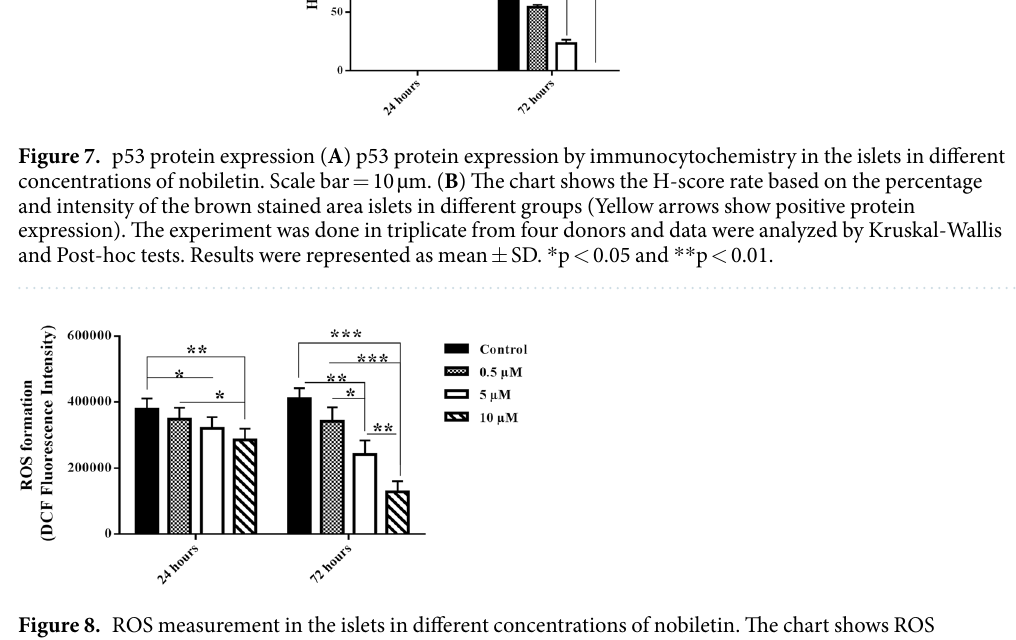
Figure 8. ROS measurement in the islets in different concentrations of nobiletin. The chart shows ROS formation based on DCF fluorescent intensity. The experiment was done in triplicate from four donors and data were analyzed by Kruskal-Wallis and Post-hoc tests. Result were expressed as mean ± SD. * p < 0.05, ** p < 0.01, and *** p <